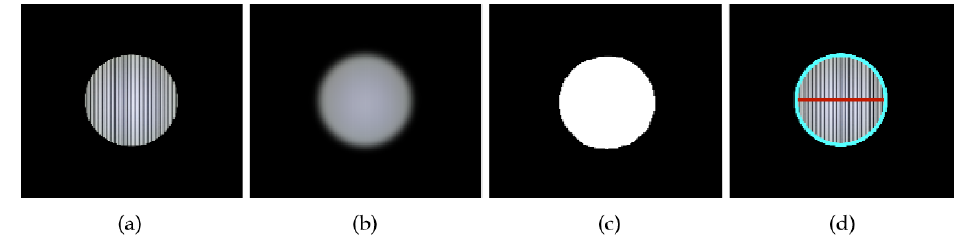
Figure 2. RoI extraction steps based on computer vision technology: ( a ) Original Image. ( b ) Gaussian Blur. ( c ) Image Binarization. ( d ) Contour Recognition and Pixel